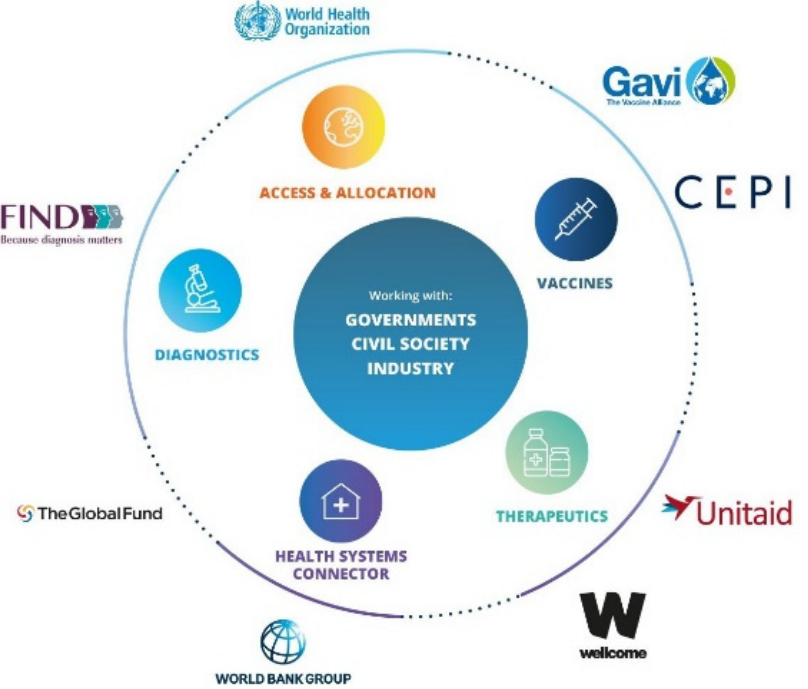
Figure 9. The Foundation for Innovative New Diagnostics (FIND) has partnered with several lead- ing global organizations for the rapid development, scale-up, and universal access to COVID-19 diagnostics, vaccines, and therapeutics. The figure is reproduced under the Creative Commons li- cense from the World Health Organization (WHO) publication